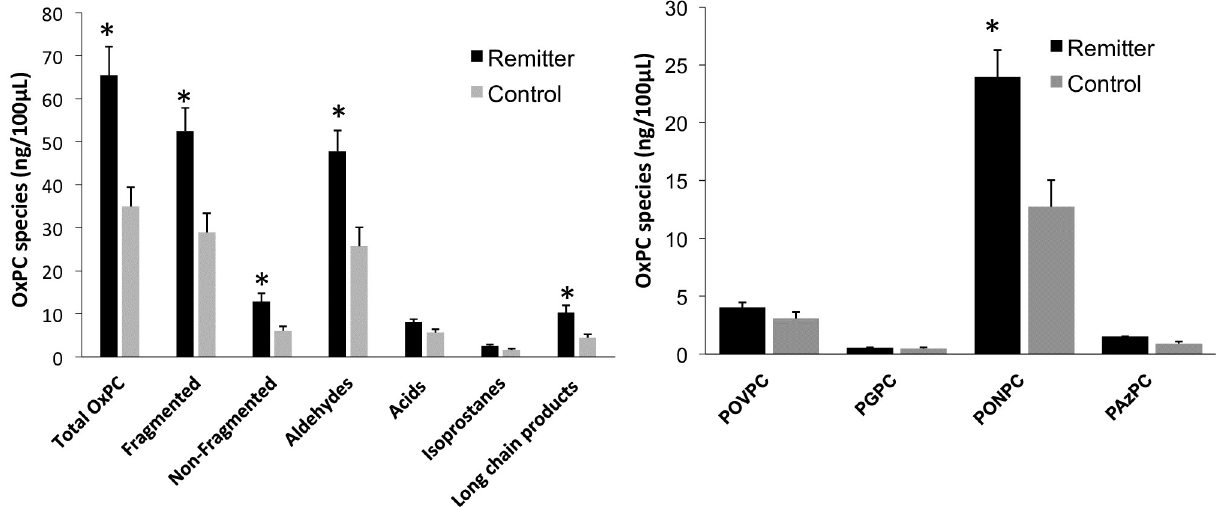
Fig 4. Baseline OxPC levels divided into total OxPCs with subgroups [A] and 5 specific OxPC compounds [B] compared between MDD subjects who entered remission after rTMS [n = 22] and control subjects [n = 9]. Values are mean+SEM. � = p < 0.05.